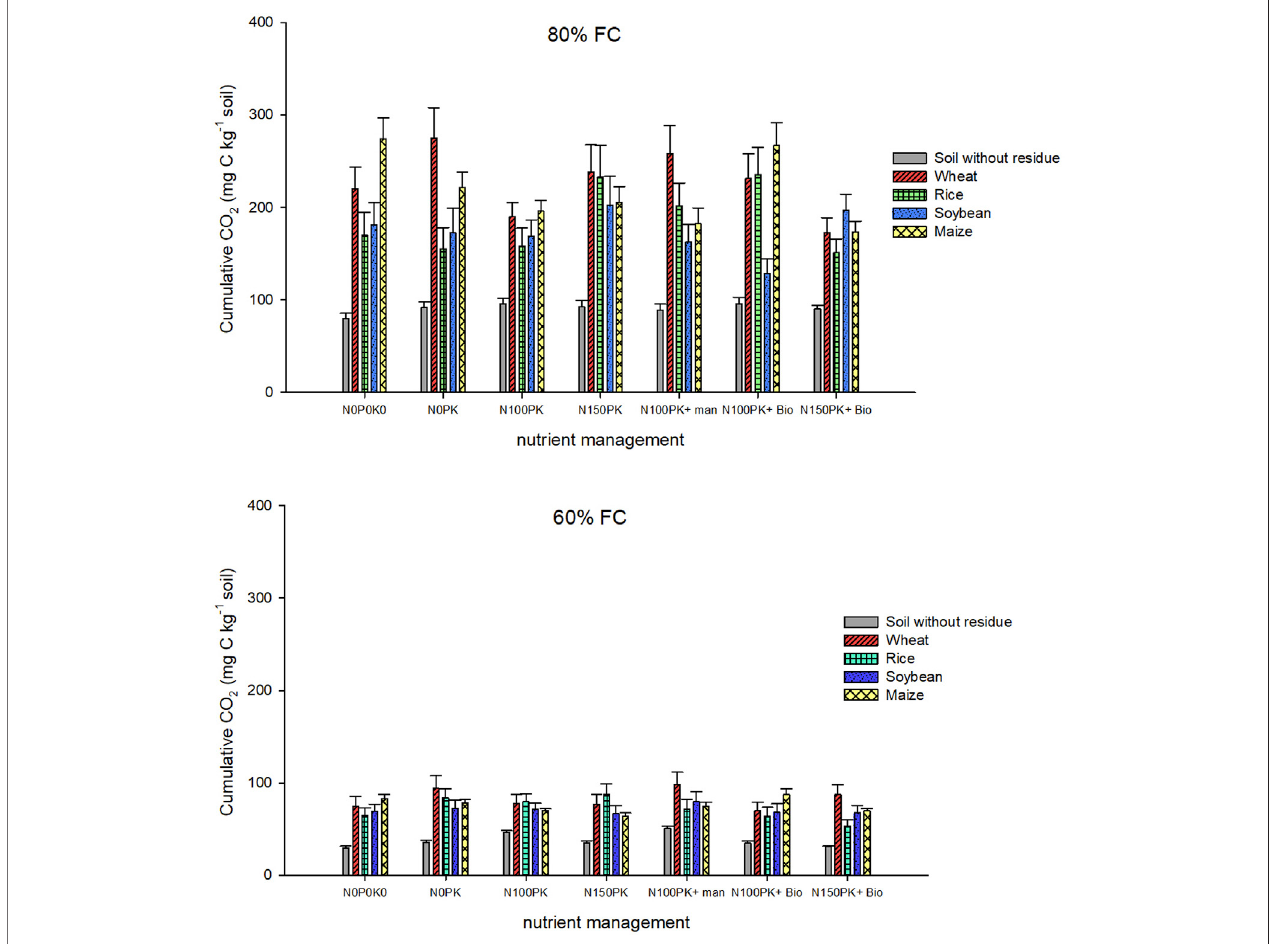
FIGURE 4 | Cumulative soil CO 2 respiration (mg-C kg − 1 soil) as in fl uenced by residue types, nutrients, and soil moisture after 87 days of incubation. Details of statistics of cumulative CO 2 -C mineralization are provided in Table 4 .